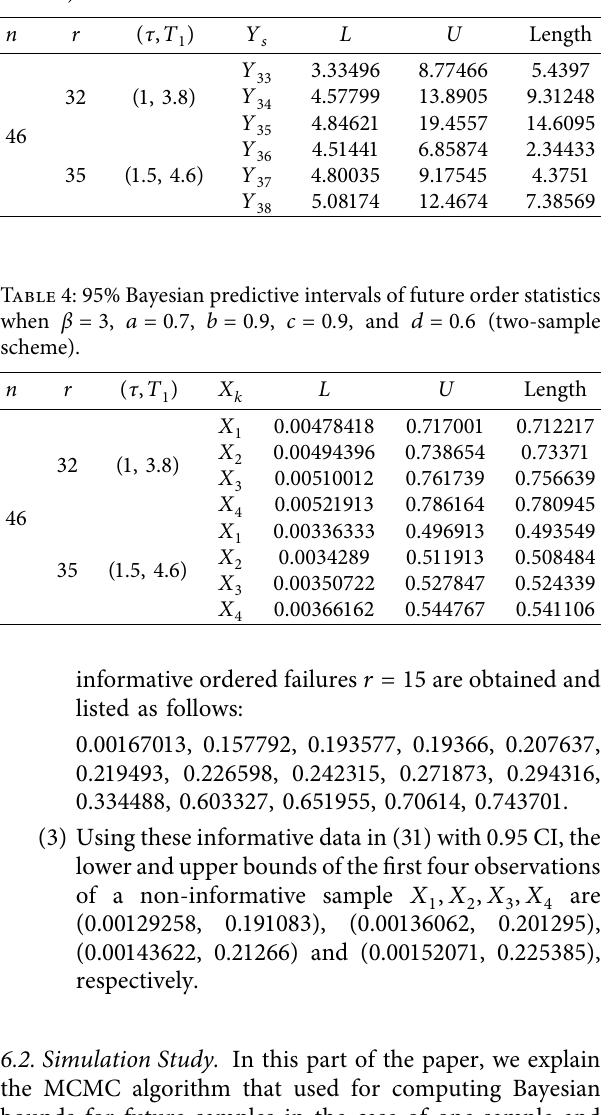
Table 3: 95% Bayesian predictive intervals of future order statistics when β � 3, a � 0 . 7, b � 0 . 9, c � 0 . 9, and d � 0 . 6 (one-sample scheme).